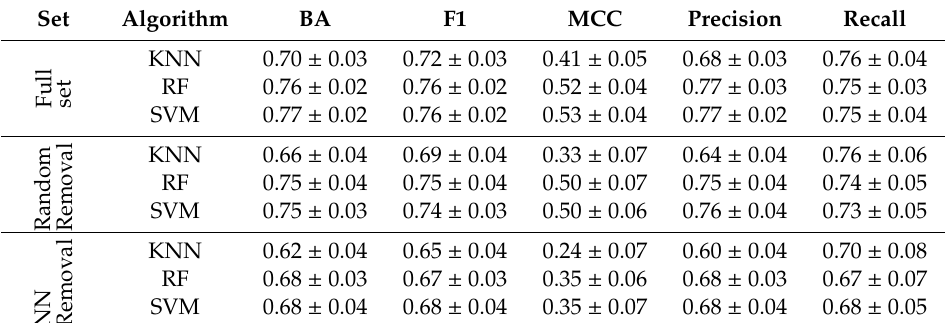
Table 4. Prediction accuracy for single- versus multi-target compounds from biochemical assays.